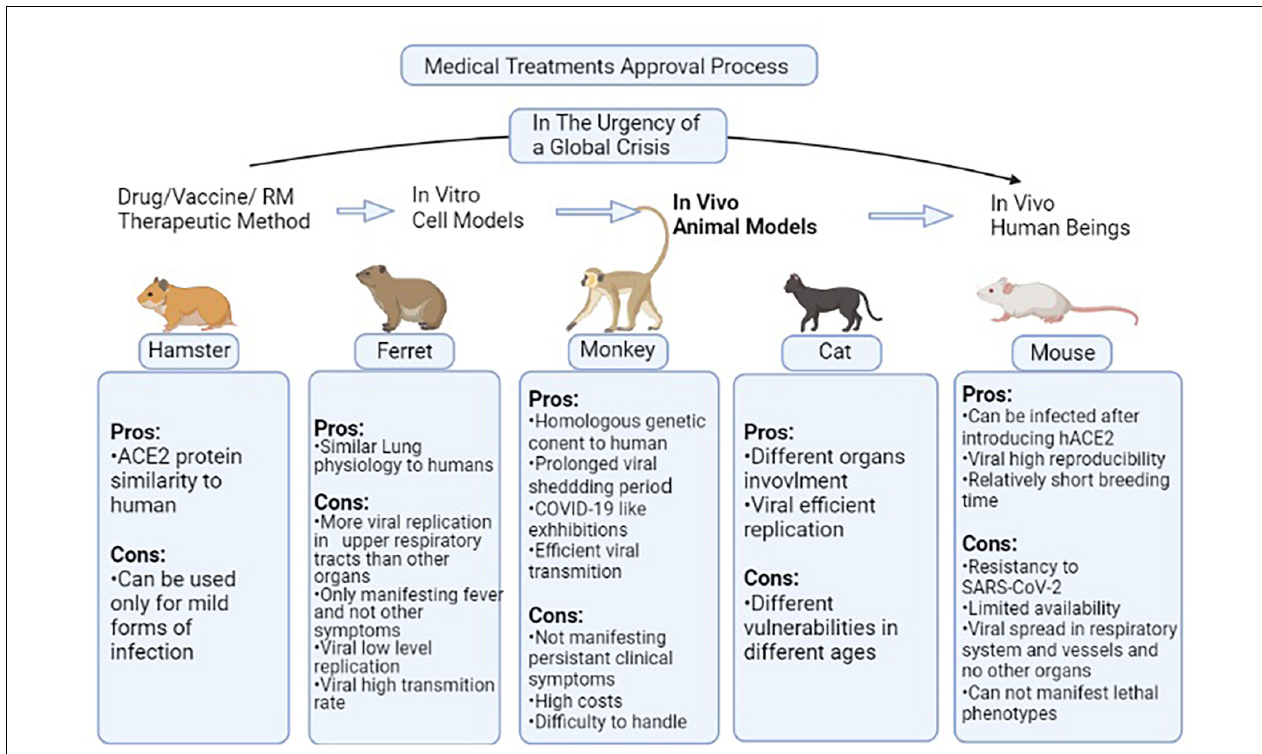
FIGURE 2 | Pros and cons of each species model discussed in Table 1 . In non-critical situations, the routine process of a medical treatment to be approved begins from in vitro level of experiment and passes toward human experiments through passing the animal model testing stage. In the situation of global crisis such as the COVID-19 pandemic, the in vitro and animal model testing stages are not much focused on and the candidate therapeutic methods are directly applied to volunteers. But this gap has to be filled as soon as possible in order to reduce the drug/vaccines/Regenerative Medicine (RM) therapies rate of error. This figure provides the pros and cons of different species models in the case of studying animal models used in this field (Kumar et al., 2020; Rahim and Muhammad, 2020; Zheng et al., 2021). ACE2, Angiotensin-converting enzyme 2; hACE2, human-ACE2; SARS-COV2, Severe acute respiratory syndrome coronavirus 2; RM, Regenerative